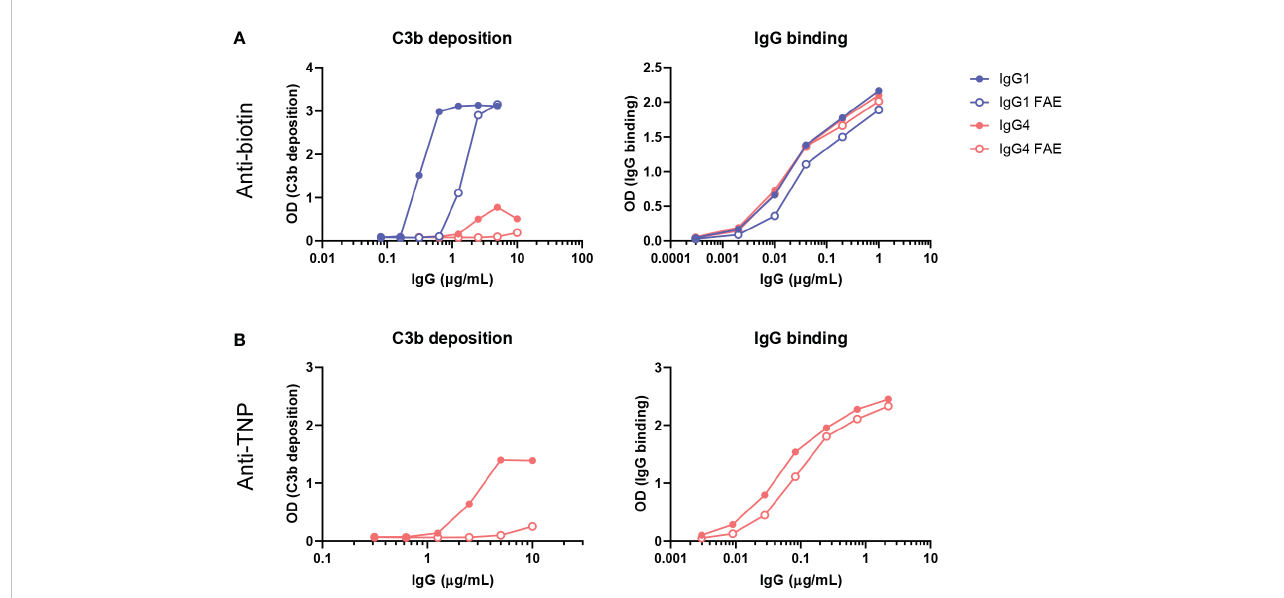
FIGURE 5 Fab arm exchange reduces antibody-mediated C3b deposition. Bispeci fi c IgG1 and IgG4 variants were generated by half molecule exchanging anti-biotin and anti-trinitrophenyl (TNP) clones (both normal galactosylation) with IgG1 K409R adalimumab and IgG4 natalizumab respectively under mild reduction conditions. C3b deposition by (A) anti-biotin and (B) anti-TNP monospeci fi c (full dots) and bispeci fi c (empty dots) IgG1 and IgG4 in the presence of either TNPlated (1 mM 2,4,6-trinitrobenzenesulfonic acid) or biotinylated (240 m M biotin) human serum albumin and 2.5% human serum was tested. Binding to either biotin or TNP was measured for all variants (right panel). All experiments were performed at least three times, shown are representative fi